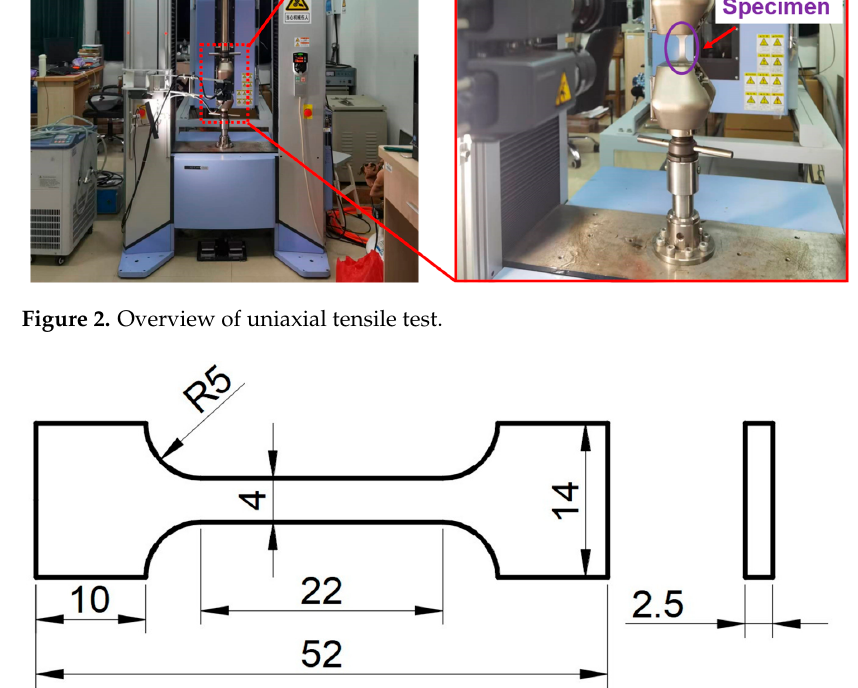
Figure 3. Dimensions of the tensile specimen (mm).